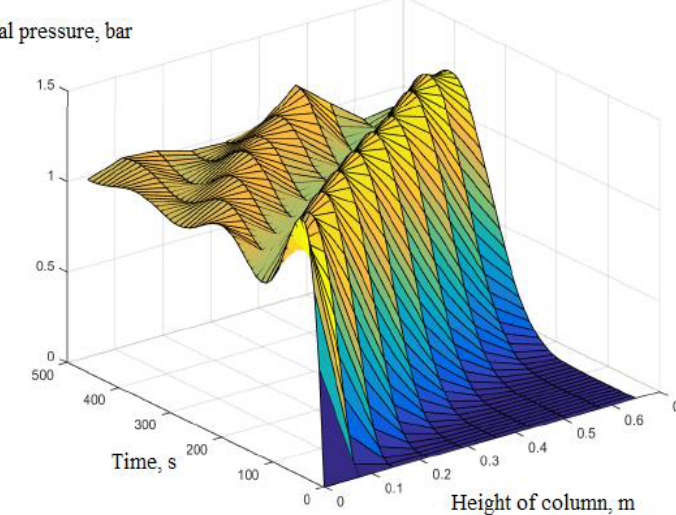
Figure 7. The result of partial pressure (O 2 ) following over time and height of column at 5.5 bar.